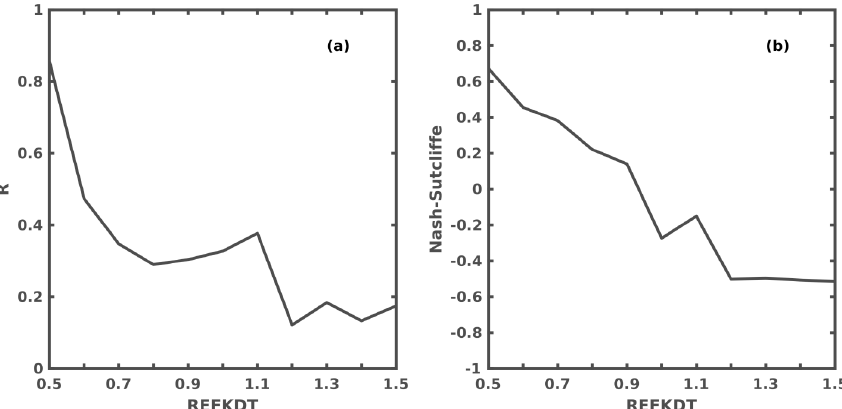
Figure 4. (a) The correlation and (b) the Nash–Sutcliffe coefficient between the observed and simulated discharge for each possible value of REFKDT for Sarantapotamos basin, after the 5h displacement of the temporal evolution of the simulated